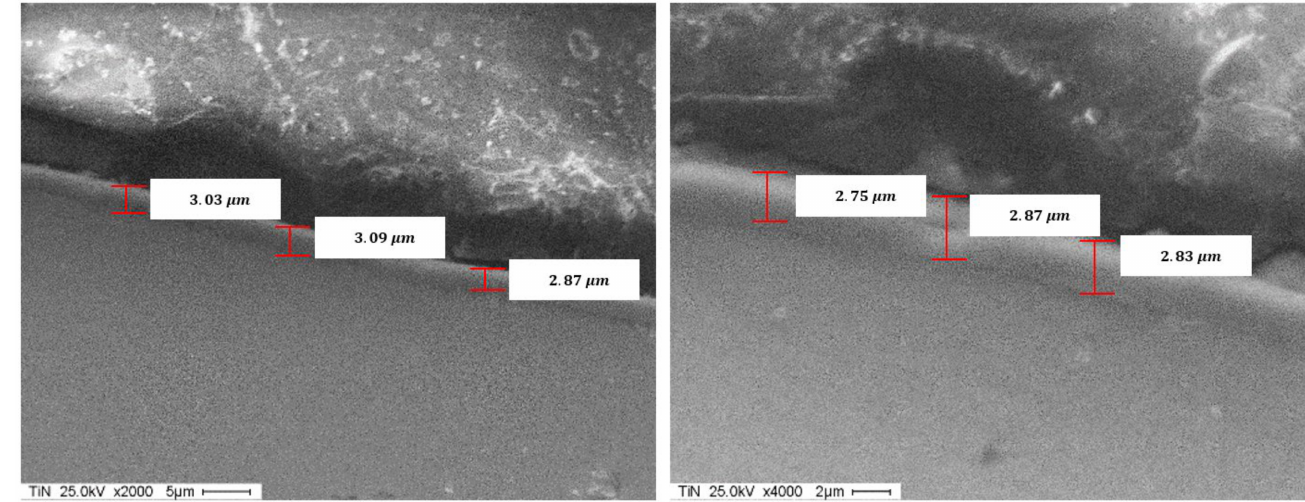
Figure 12. SEM of the TiN coating.